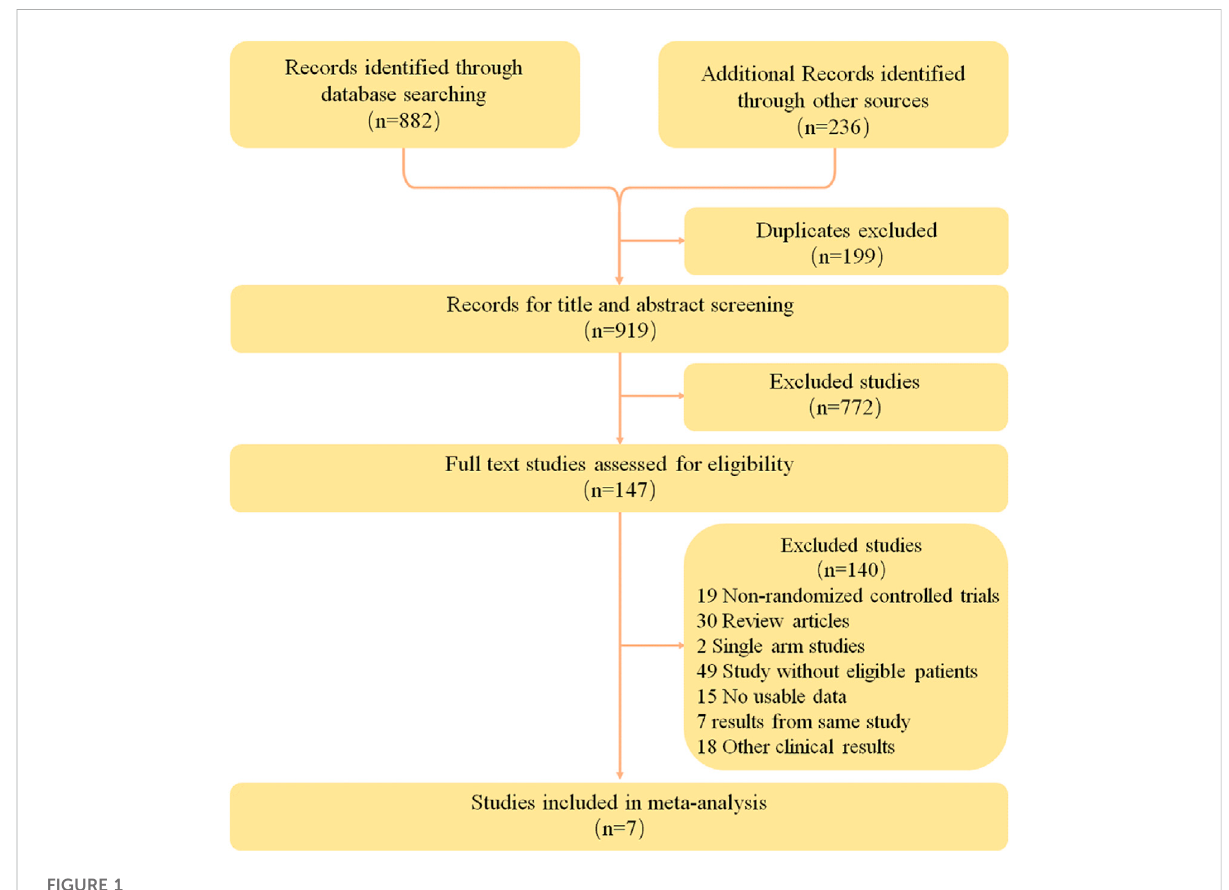
FIGURE 1 PRISMA Flow Diagram of Study Selection for this